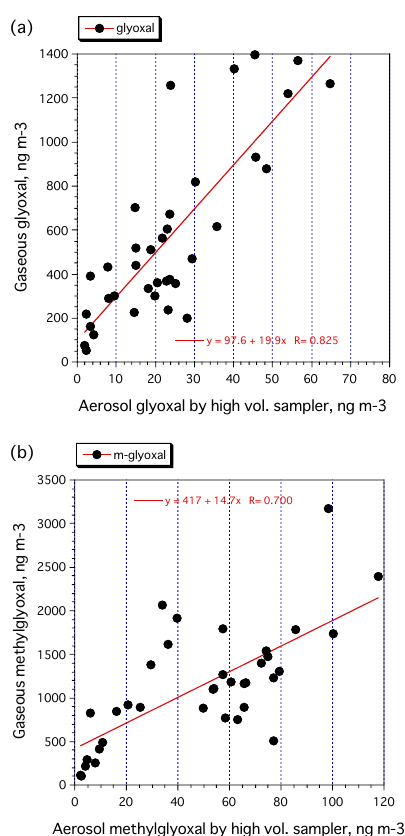
Fig. 9. Relationship between the concentrations of (a) gaseous glyoxal (ng m − 3 ) measured in this study and particulate glyoxal measured in aerosol samples (TSP) from Mt. Tai and (b) gaseous methylglyoxal and particulate methylglyoxal. The data of particu- late glyoxal and methylglyoxal were obtained from the aerosol sam- ples, which were collected simultaneously at Mt. Tai and analyzed by capillary GC using derivatization to dibutoxy acetals (Kawamura et al., 2013).